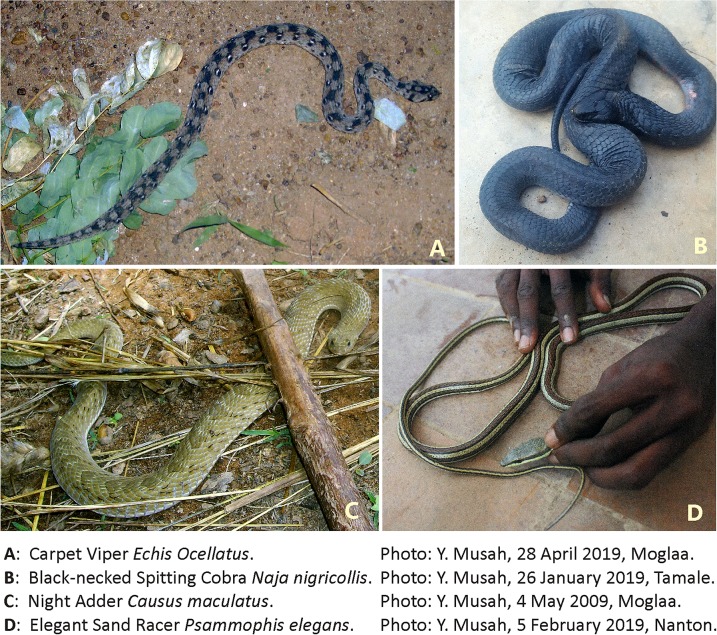
Top-Left (A): Carpet Viper Echis ocellatus (Y. Musah, 28 April 2009, Moglaa). Top-Right (B): Black-necked Spitting Cobra Naja nigricollis (Y. Musah, 26 January, 2019 Tamale). Down-Left (C): Night Adder Causus maculatus (Y. Musah, 4 May 2009, Moglaa). Down-Right (D): Elegant Sand Racer Psammophis elegans (Y. Musah, 5 February 2019, Nanton).